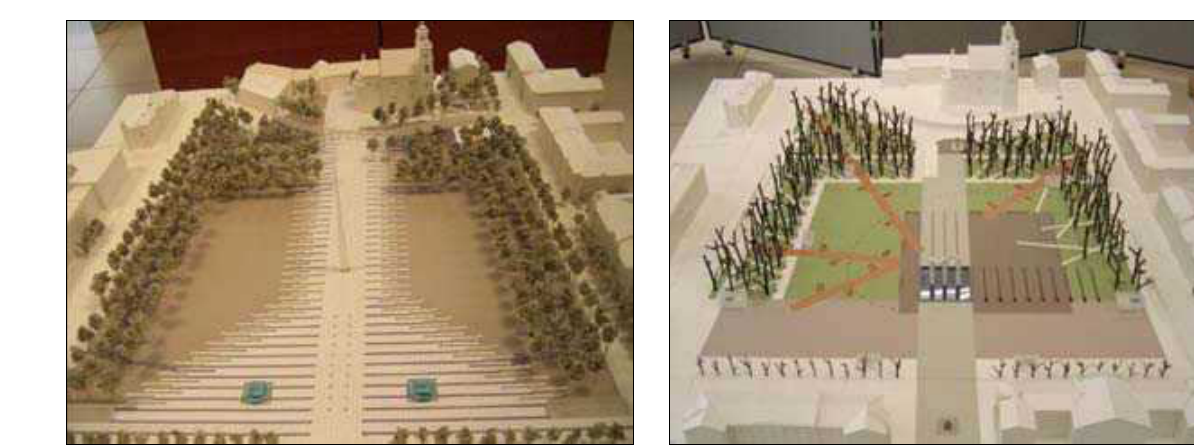
7 pav. Lukiškių aikštės sutvarkymo konkursinis projektas. k. antanėlis, D. regelskis, V. e. Čekanauskas, 2009 Fig. 7. Lukiškės Square reconstruction competition.